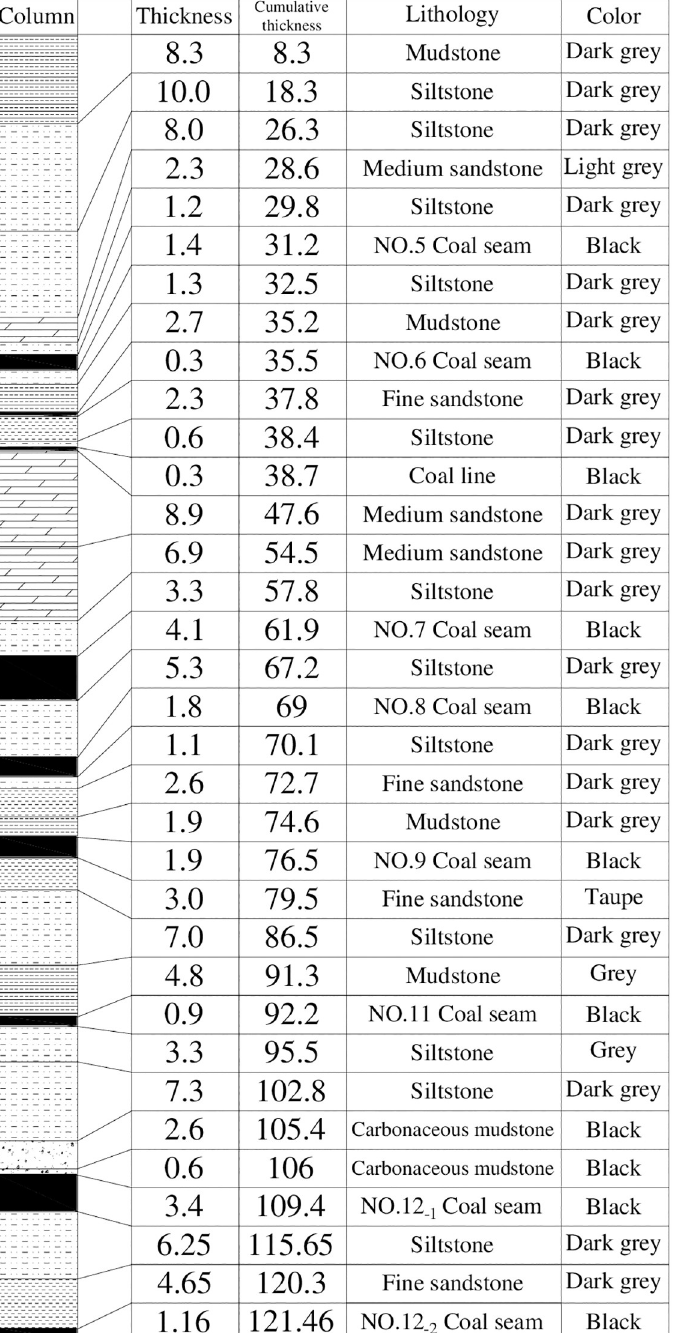
According to the paper [42] and [46], the roof structure characteristics of full-cover rock strata after coordinated mining of close-multiple coal seams were detected through ground